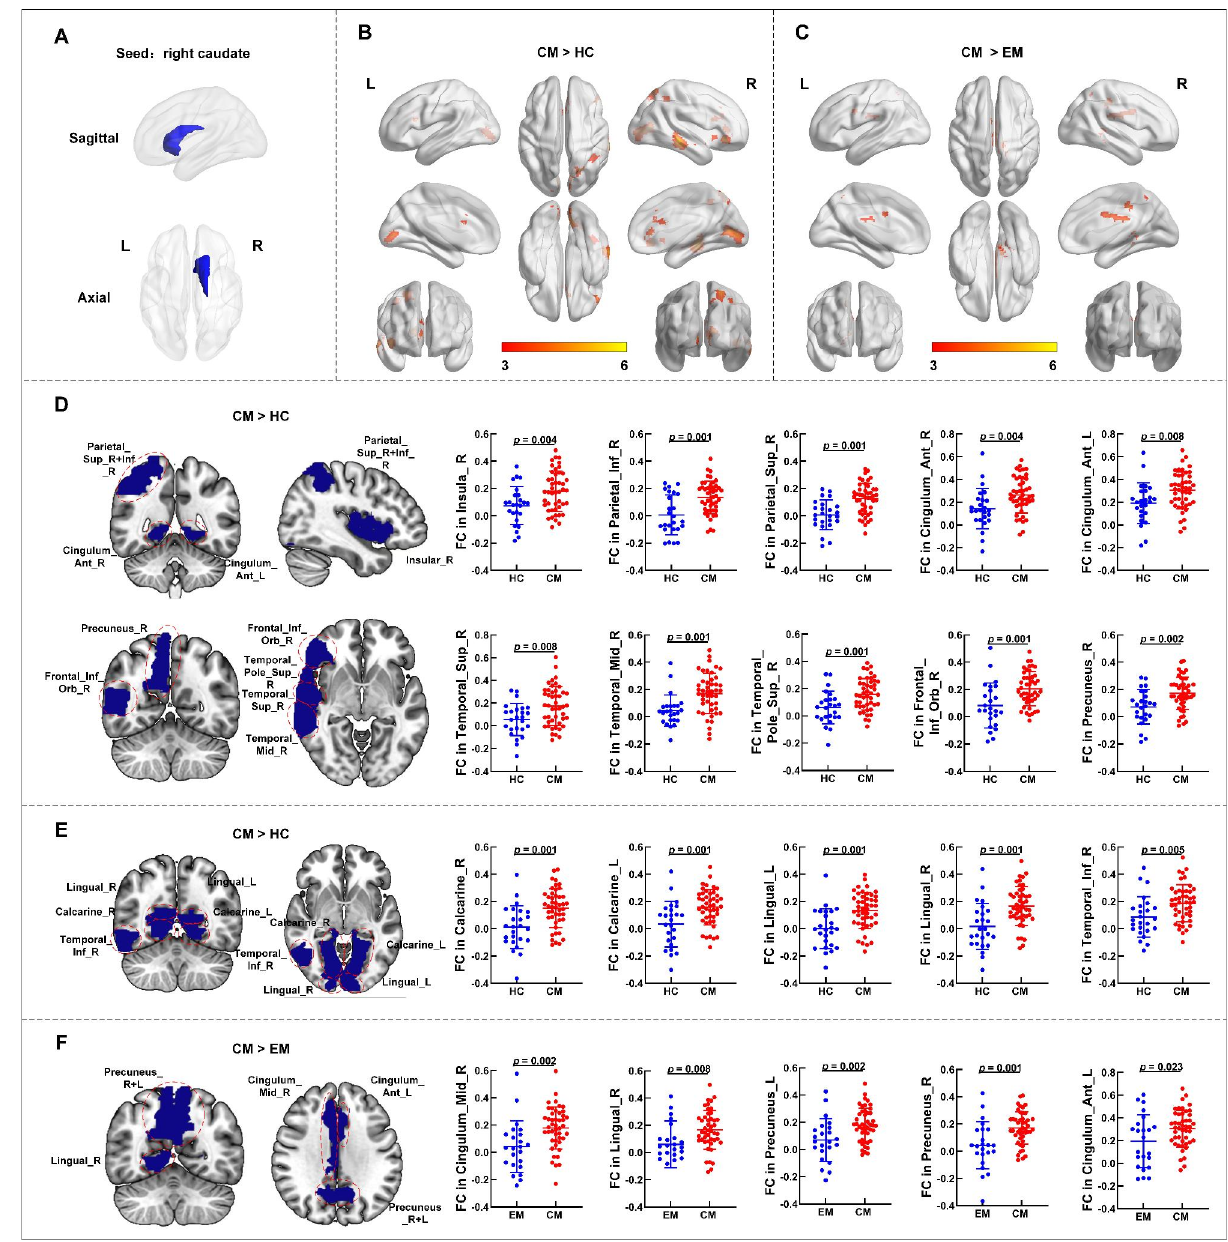
Fig. 3 Differences in the FC values of the right CN between the CM, EM, and HC groups. (A). Right CN masks generated based on the automated anatomical labeling atlas. (B). When using the right CN as the seed, patients with CM show significantly higher FC values than HCs. (C). Patients with CM show significantly higher FC of the right CN than patients with EM. FC values in the (D).emotion-cognition related and (E). sensory-related brain regions show significant differences in HCs and patients with CM. (F). Patients with CM show significant FC values differences between the right CN and certain brain regions than EM patients. The color bar shows the t-values of the two-sample t-tests on FC. Note: L, left; R, right; FC, functional connectivity; CN, caudate nucleus; CM, chronic migraine; EM, episodic migraine; HC, healthy